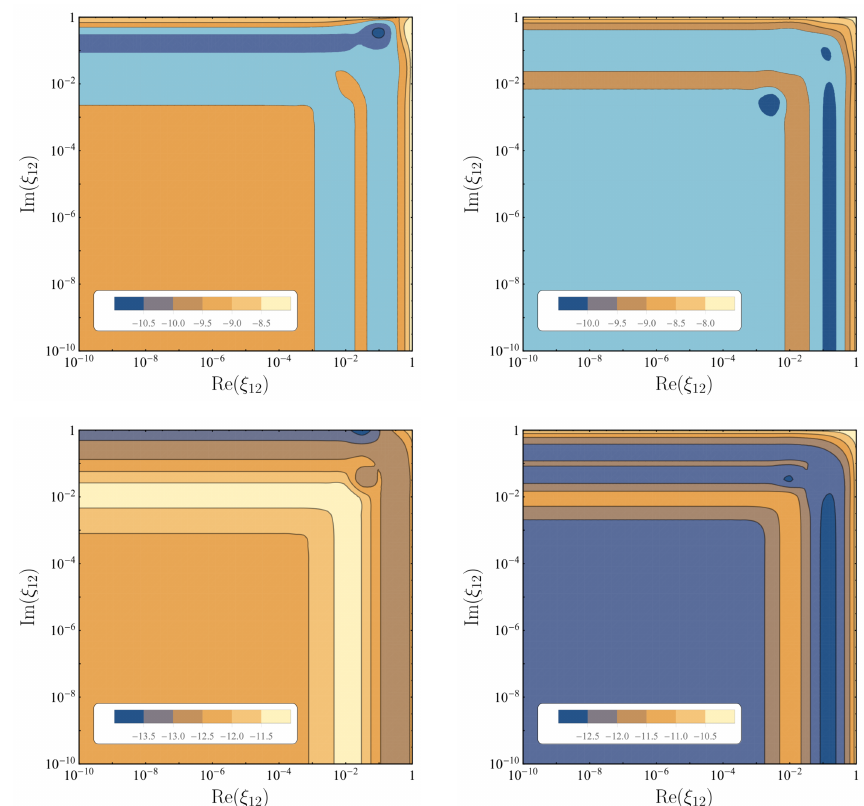
Figure 6 . The density plots of the lepton asymmetry in the (Re ξ 12 , Im ξ 12 ) plane. The upper figures show the parameter space for the normal mass hierarchy and the real (imaginary) CI parameters in the left (right) figure. The similar figures are given for the inverted mass hierarchy in the lower panels. The light blue regions properly produce the observed baryon asymmetry in the